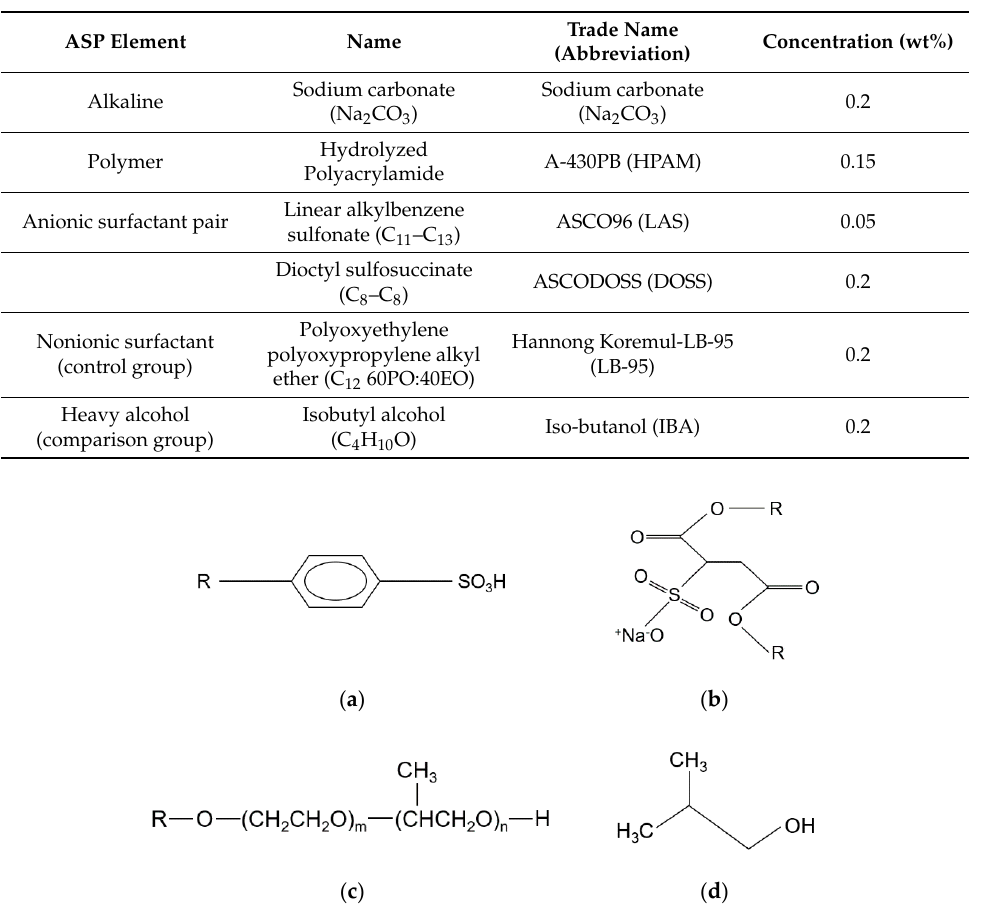
Table 2. Summary of the chemical materials as the alkaline–surfactant–polymer (ASP) components used in this study. LAS: linear alkylbenzene sulfonate; DOSS: dioctyl sulfosuccinate; HPAM: hydrolyzed polyacrylamide.